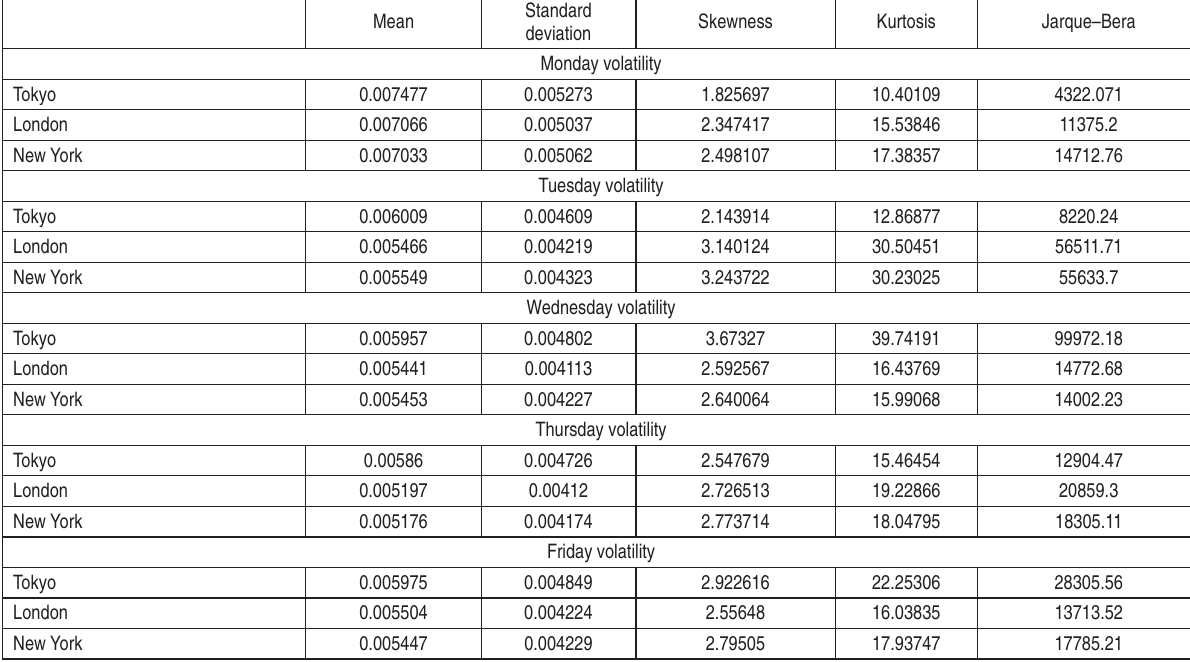
Table 5. Summary statistics of panel intraday volatility Monday to Friday in Tokyo, London and New York